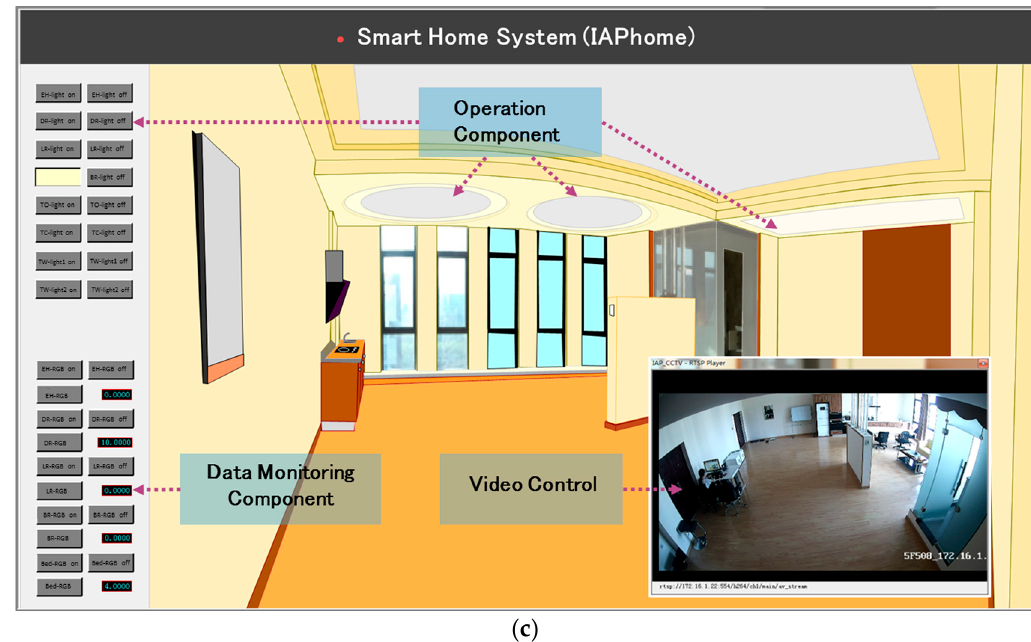
Figure 9. Graphical configuration representation of Case 1. ( a ) Partial program of the algorithmic control logic; ( b ) partial program of the communication setup logic; and ( c ) partial program of the human-machine interface program.